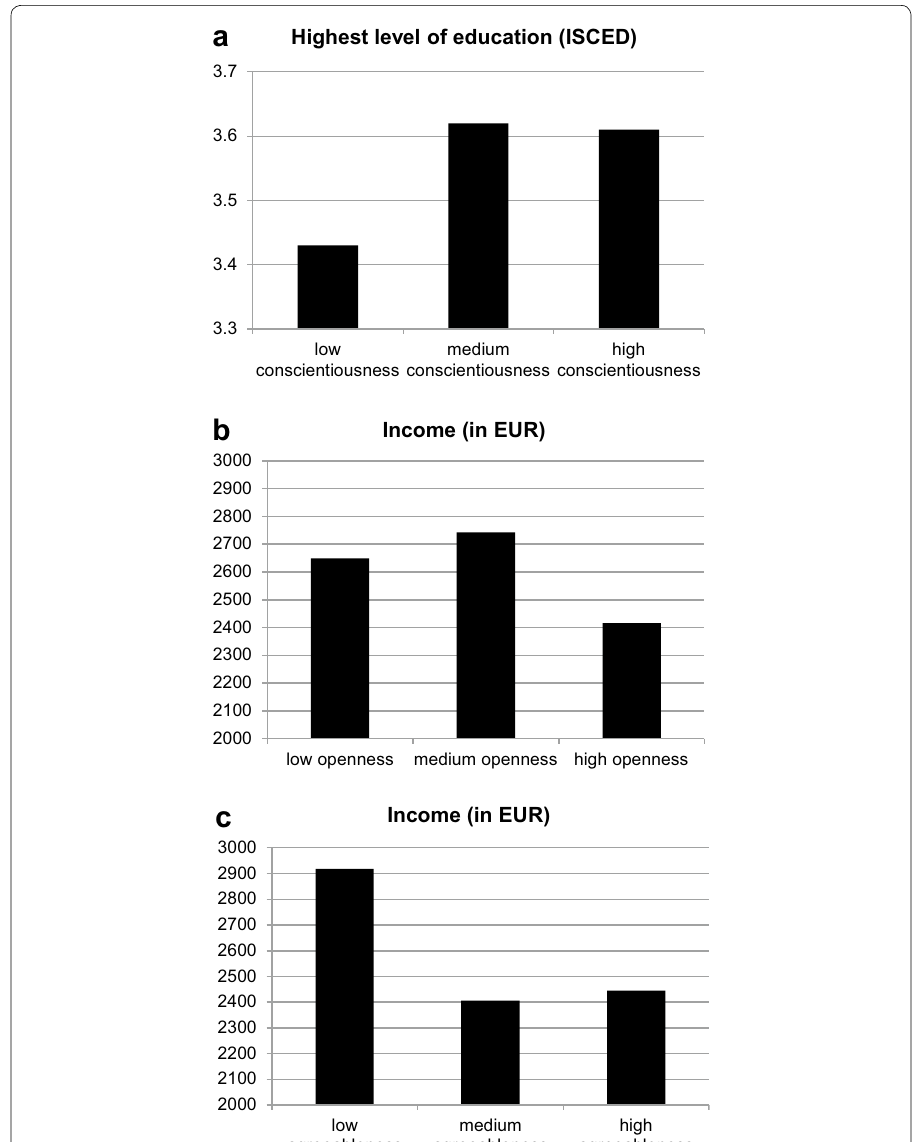
Fig. 2 Quadratic associations between the Big Five personality domains and educational attainment ( a ), and income ( b , c ) (means based on tertile